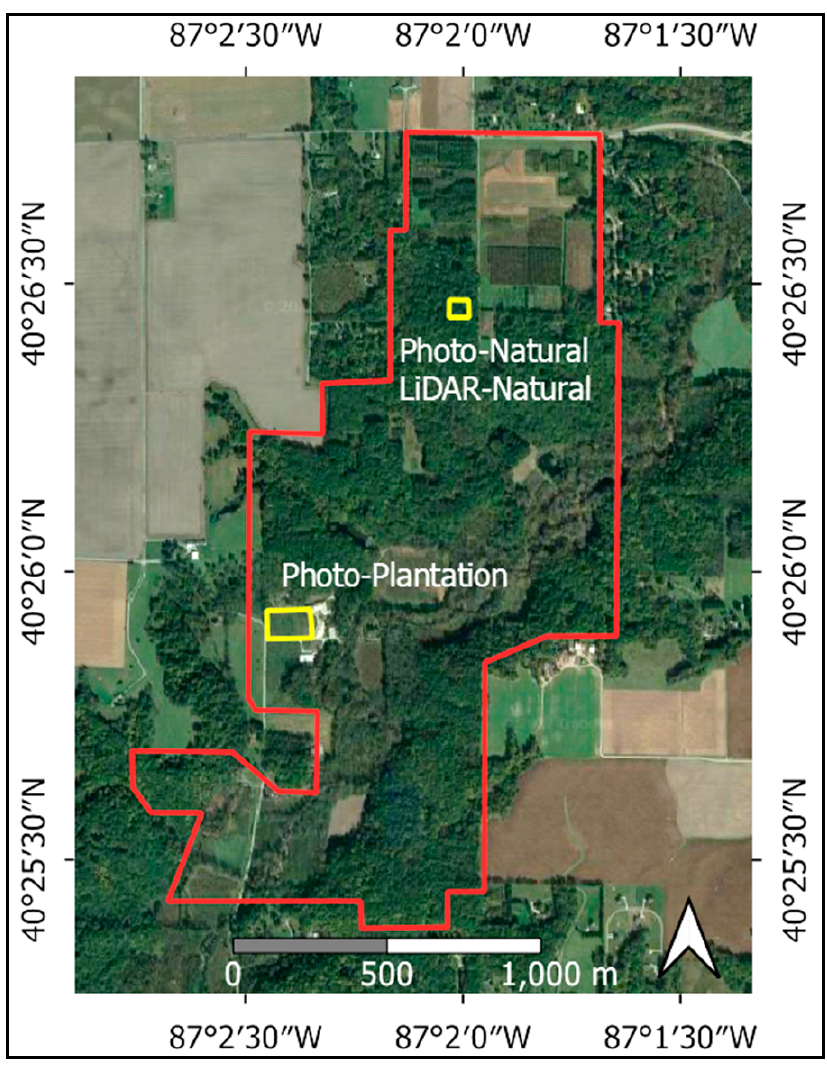
Figure 2. Map of Martell Forest, Indiana, USA. The red outline shows the forest’s boundaries. The yellow outlines show the location of the data collection sites.